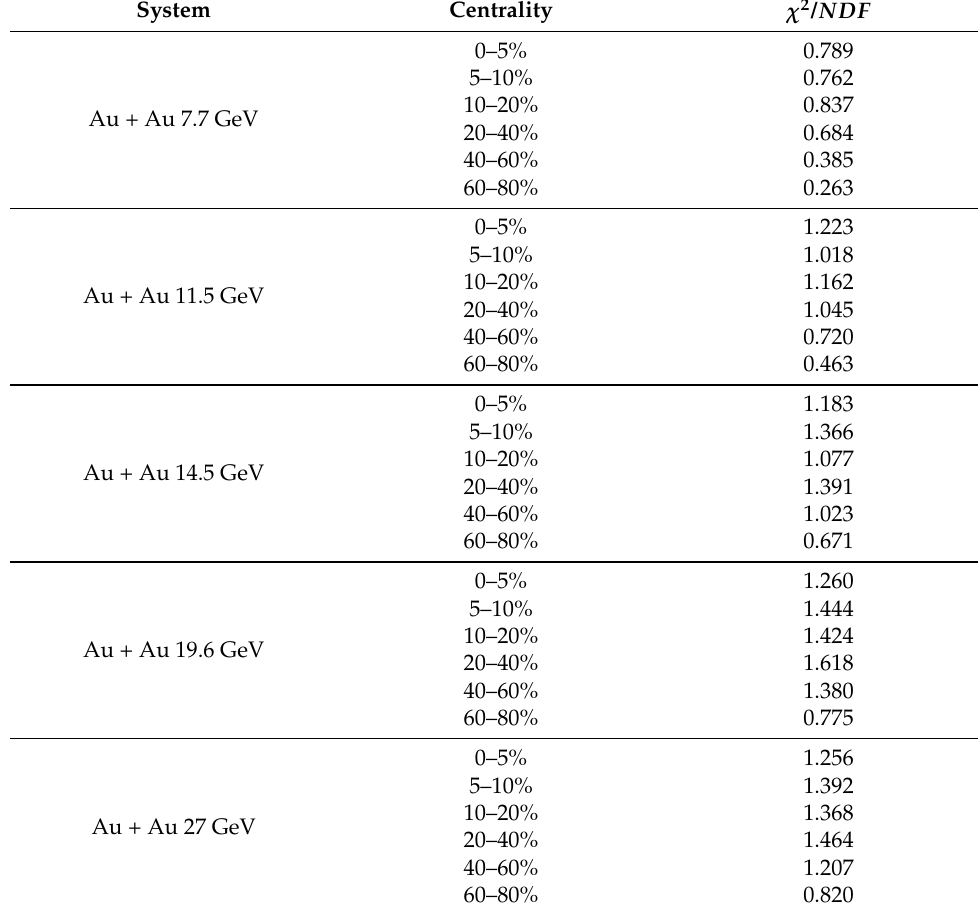
Table A1. The χ 2 / NDF of the fitting results in Figure